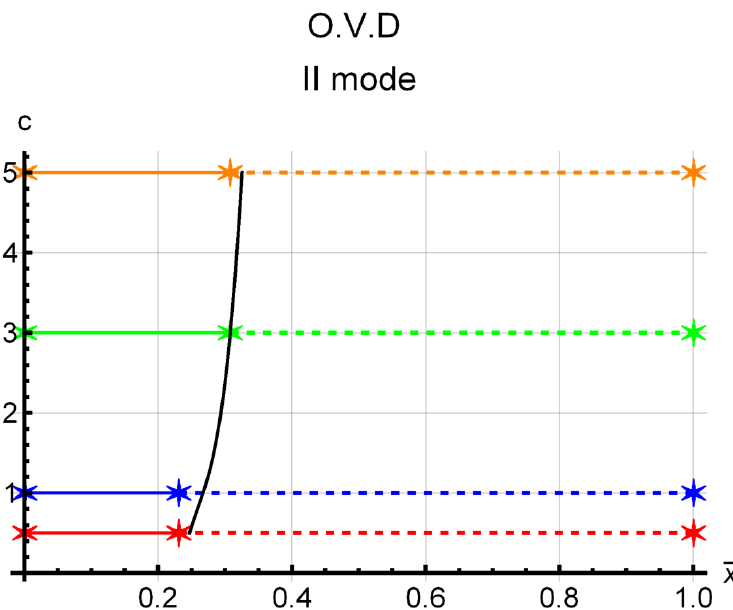
Figure 11. Analytical and numerical optimal voltage distributions (O.V.D.) for the second eigenmode excitation versus tapering ratio. Black lines highlight the analytical location of the points beyond which the voltage should be applied with the opposite phase with respect to the previous region. The dashed lines identify the PZT couples that have to be supplied with the opposite voltage sign. The stars represent the numerical optimal voltage distribution for each c value, calculated considering 13 PZT couples.